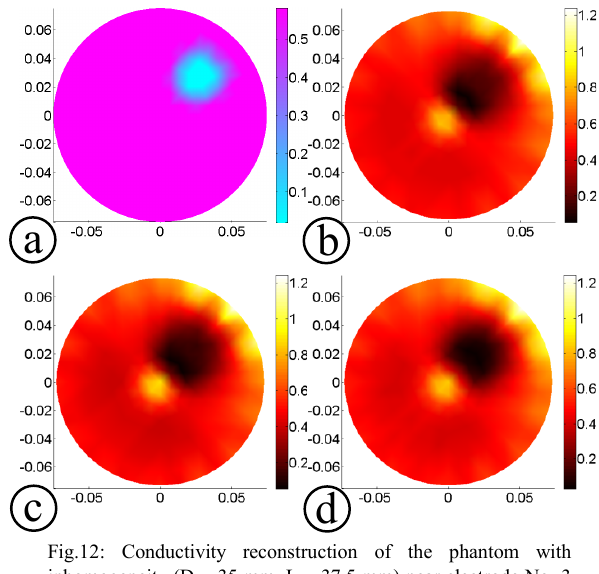
Fig.12 : Conductivity reconstruction of the phantom with inhomogeneity (D = 35 mm, L = 37.5 mm) near electrode No.-3 ( λ = 0.0001 ): (a) original object, (b) image with STR, (c) image with LMR, (d) image with BMMR. Table-8: CNR, PCR and COC of the conductivity images of Fig. -12 37.5 mm Dis t .